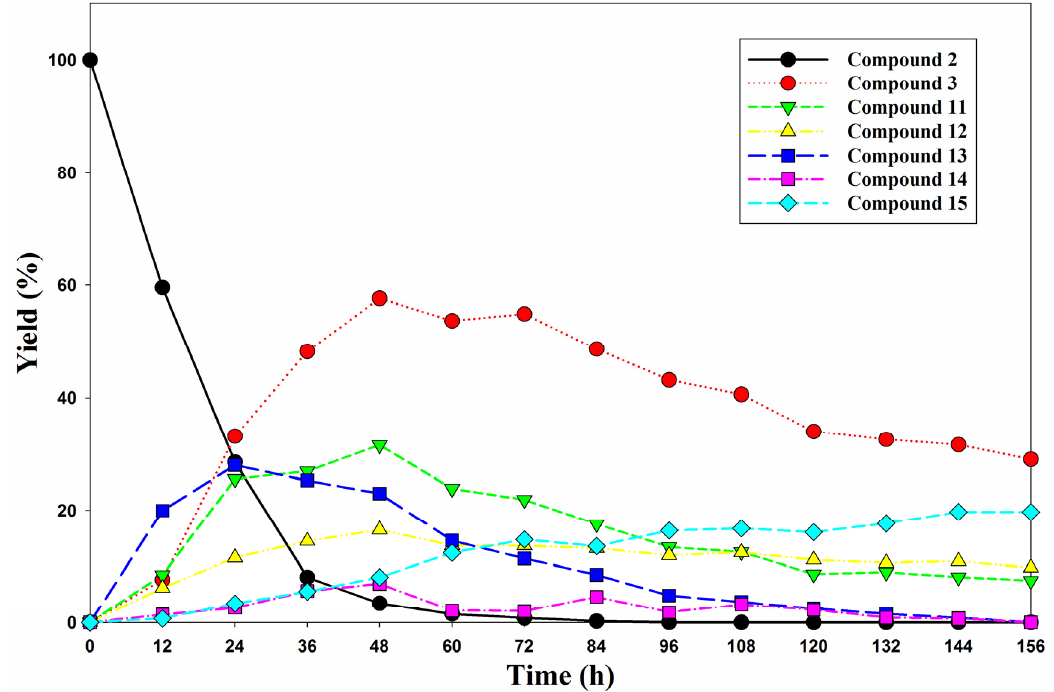
Figure 3. Distribution of products in the decomposition of 2 at various reaction